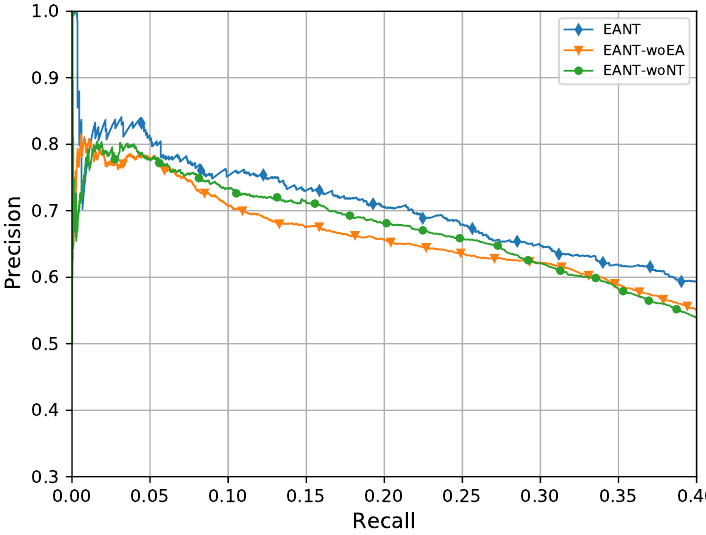
Figure 4. Comparison of EANT variant